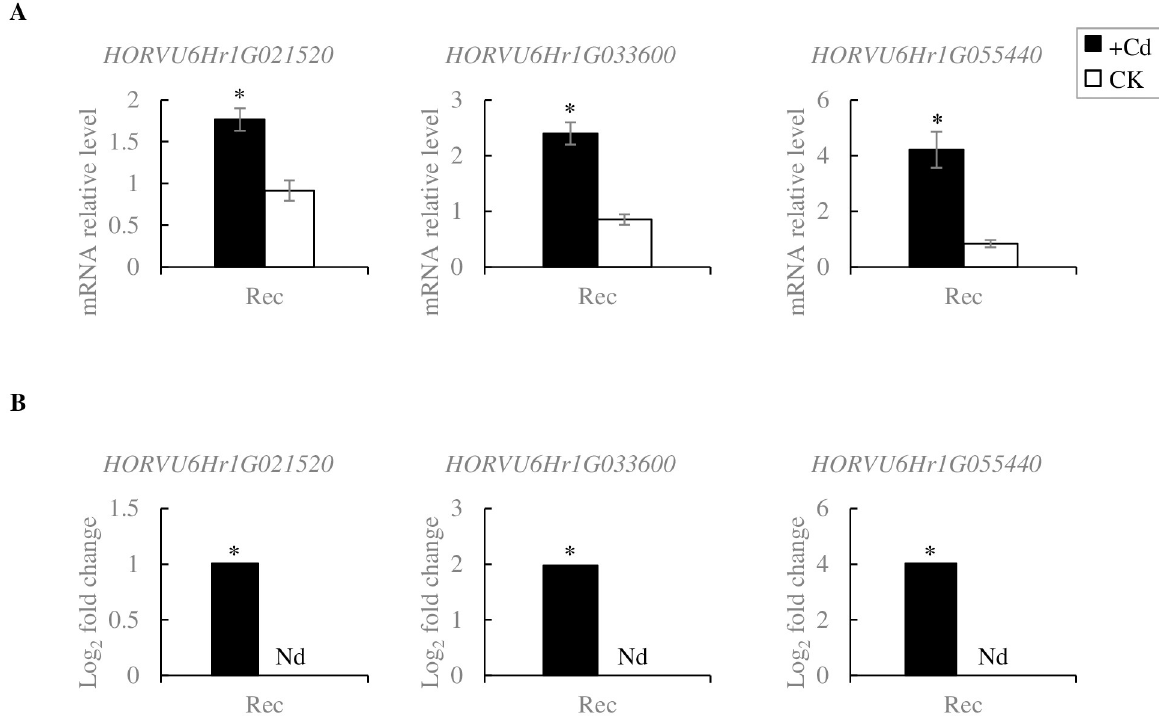
(S3 Table). A total of 19 DEGs (specifically upregulated in Rec.Cd vs Dom.Cd comparison) and 951 genes harboring variants (seven overlapping genes with DEGs) were co-localized with the detected QTLs (S11 Table). A BLASTP search for sequences with homology to the Arabi- dopsis thaliana led to the identification of 16 Cd stress-related genes on chromosomes 2H and 6H based on three criteria, including upregulated DEGs in Rec.Cd vs Dom.Cd, genes contain- ing variants and the function of genes (metal ion transporters) located in the QTL regions. We identified three oxidative stress-related DEGs located in the major QTL on chromosome 6H, including peroxidase P7 ( HORVU6Hr1G021520 ), lipoxygenase 2 . 3 ( HORVU6Hr1G033600 ) and glycine rich RNA-binding protein Grp2A ( HORVU6Hr1G055440 ) genes among the 246 Cd-upregulated DEGs in Rec. The upregulation of these candidate genes was confirmed by qRT-PCR and showed similar results to those of RNA-Seq analysis (Fig 5A and 5B). We selected genes containing variants in the QTL regions, which may cause amino acid sub- stitution, including zinc transporter 2 ( HORVU6Hr1G018070 ), ABC transporter G family mem- ber 36 ( HORVU6Hr1G019080 ), copper-transporting ATPase HMA5 ( HORVU6Hr1G033380 ), peroxidase 39 ( HORVU6Hr1G026230 ), phospholipid hydroperoxide glutathione peroxidase ( HORVU6Hr1G063830 ), serine/threonine-protein kinase OXI1 ( HORVU6Hr1G054770 ) and mitogen-activated protein kinase kinase kinase YODA ( HORVU6Hr1G064150 ), in the major QTL on 6H chromosome (Table 3 and S11 Table). In the function category, we identified six proteins with metal ion binding domains, including